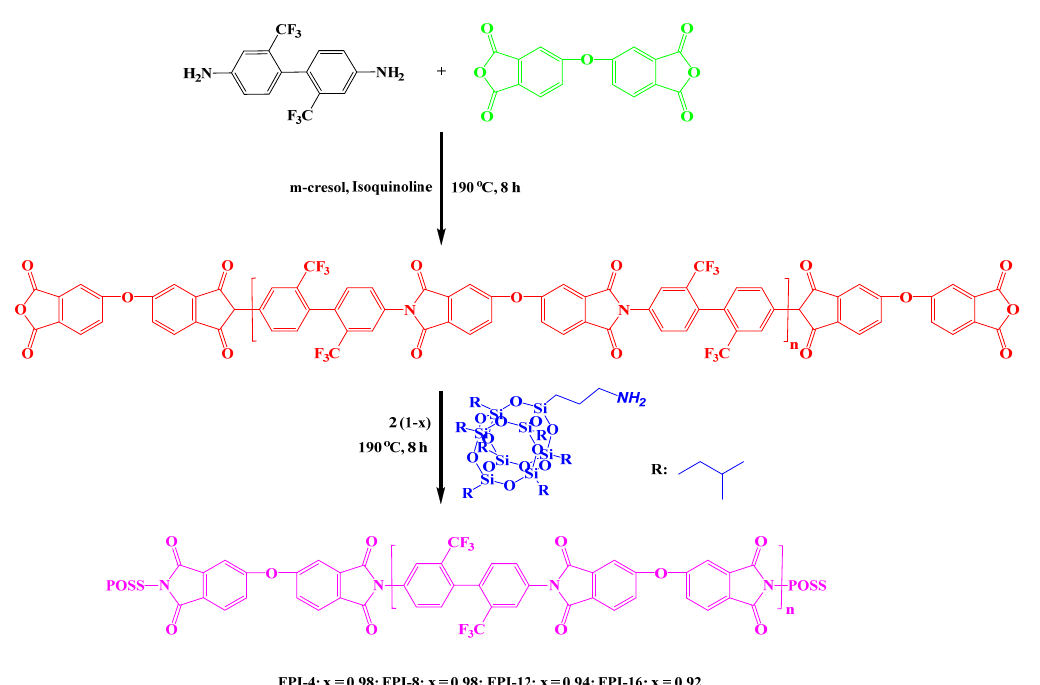
Figure 7. Synthesis of fluorinated PI/POSS hybrid nanocomposites [77]. Reproduced with permission from Springer.